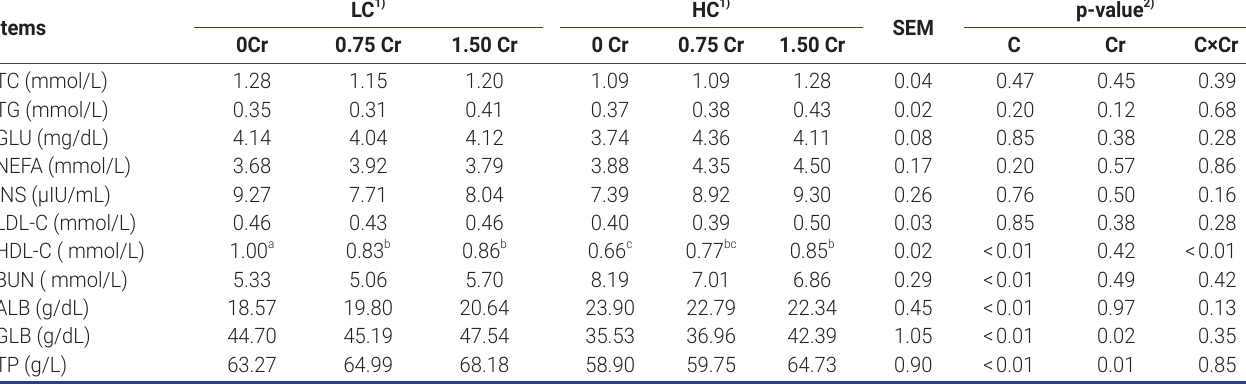
Table 5. Effects of concentrate level and Cr-Met supplementation on blood metabolites of Tan lambs